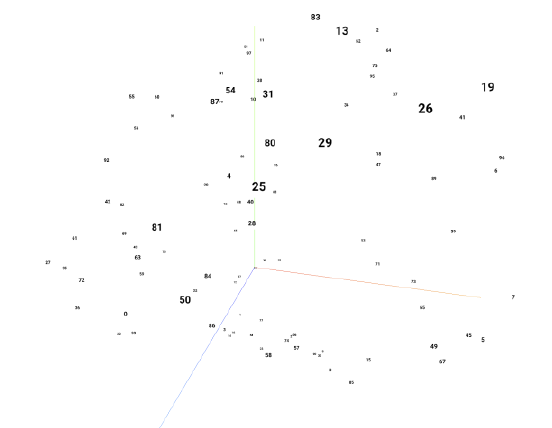
Figure 8. The demonstration of the UMAP 5 neighbors’ result.